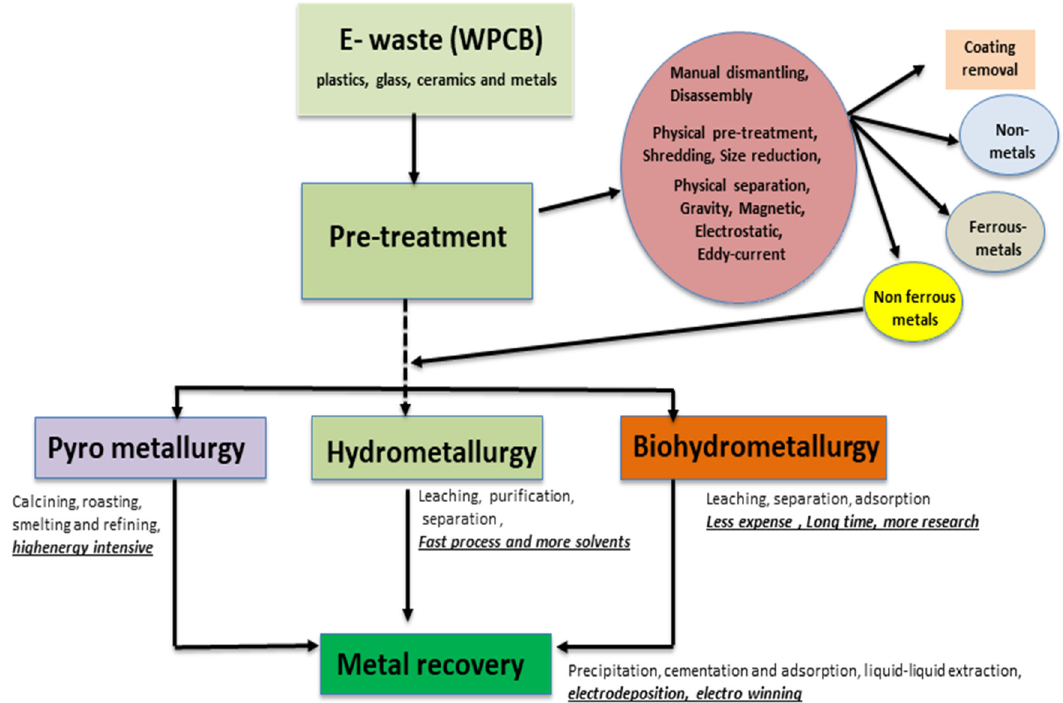
Figure 1. Scheme of metal recovery from e-waste (printed circuit boards) [9] .